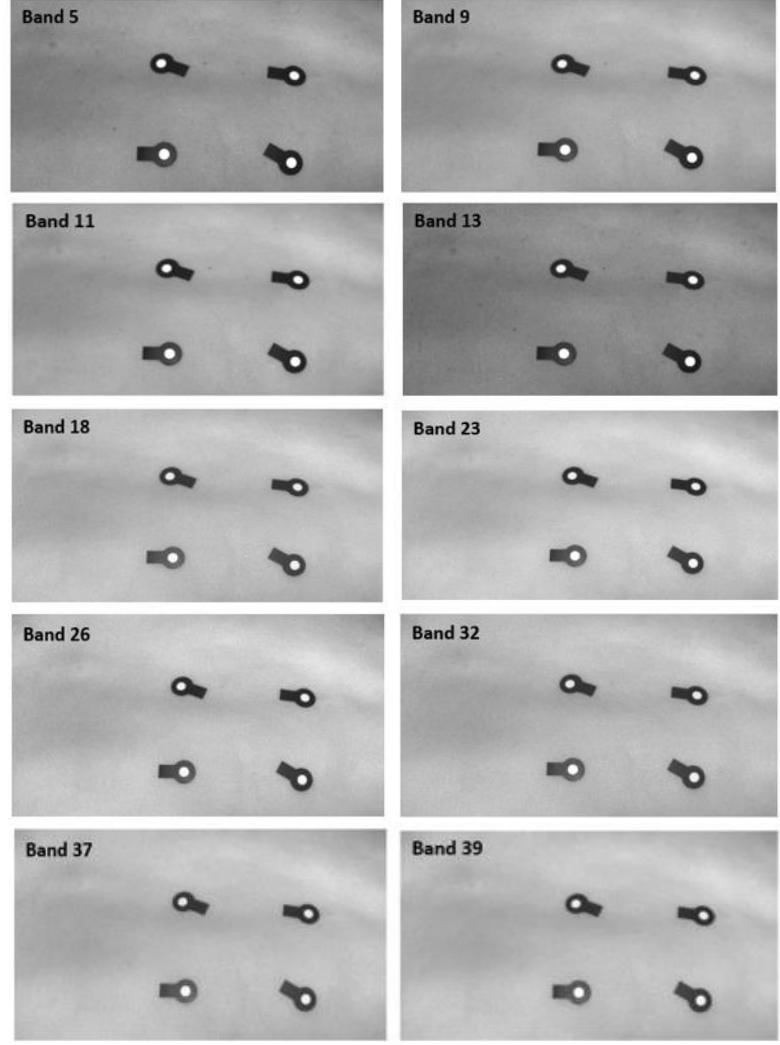
Figure 7. Ten selected bands are illustrated for subject no. 8. The bands are selected by using the Saliency-Band-Based Selection (SSBS) algorithm [31] adapted to our